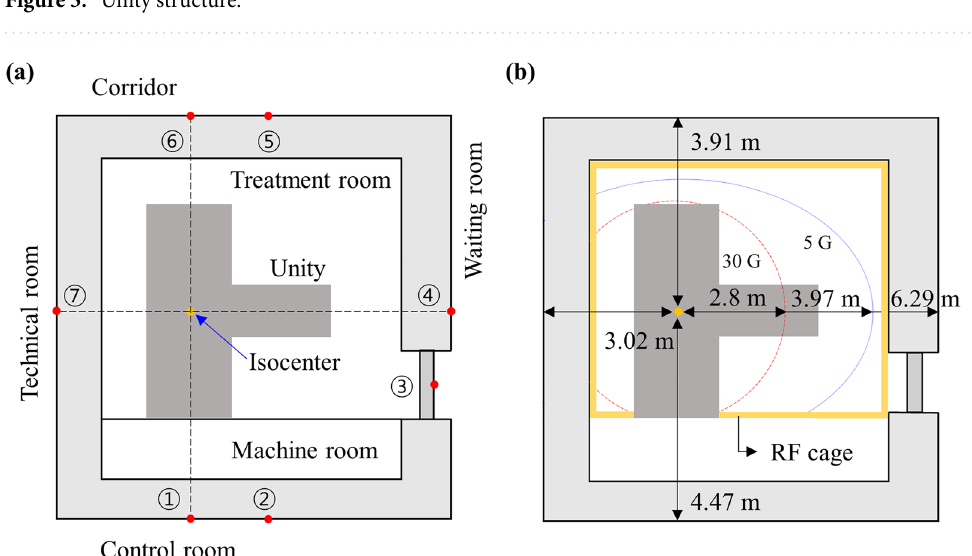
Figure 6. Unity area layout including ( a ) measurement locations (red dots) and ( b ) distances between isocenter and shielding